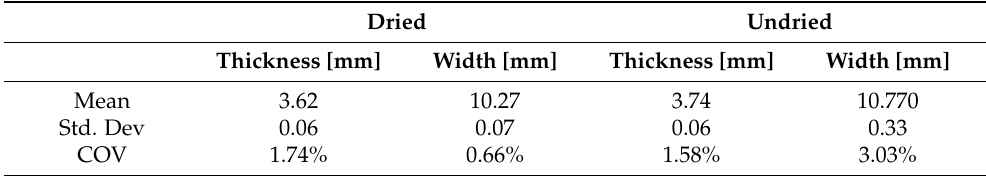
( b ) Figure 6. Tensile stress-strain curves for dried ( a ) and undried ( b ) materials. Comparing the tensile strength obtained with PEI 1000 pellet additive manufactured specimen, injection-molded (IM) ones, PEI 9085 AM and PEI 1010 AM, the results ob- tained in this work show that AM from the pellet and with proper parameters can achieve a strength comparable to injection molded PEI 1000 (Table 10).